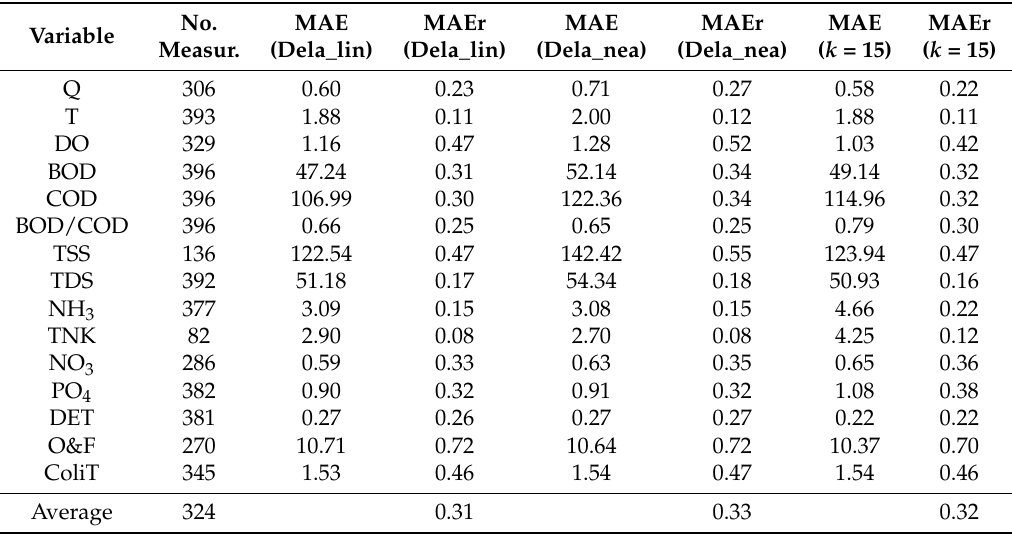
Table 3. Interpolation errors for each variable with nonuniform interpolation methods.